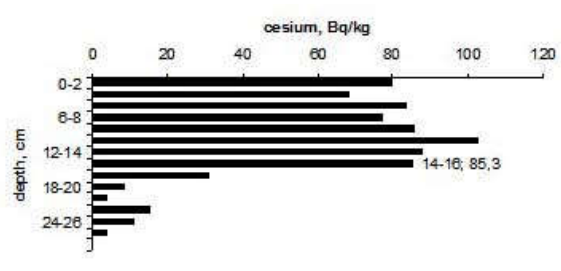
Fig ure 4 . In depth distribution diagram of caesium-137 in the zone of overplowed